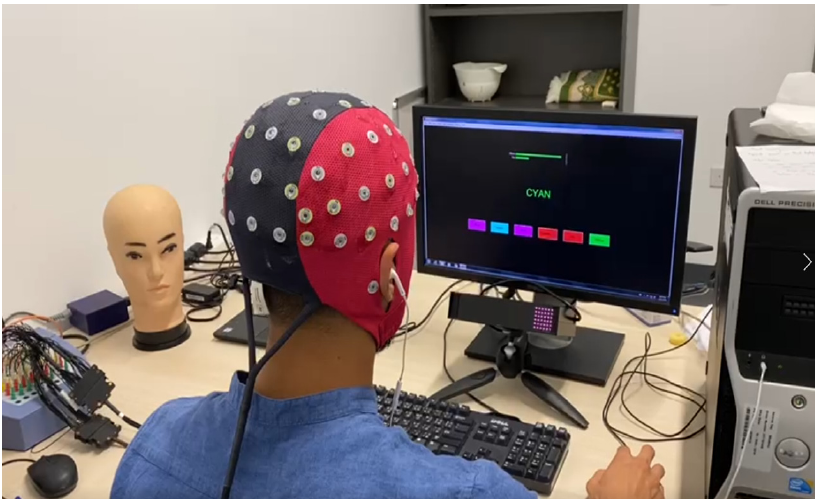
Figure 2. EEG data acquisition and experimental setup.